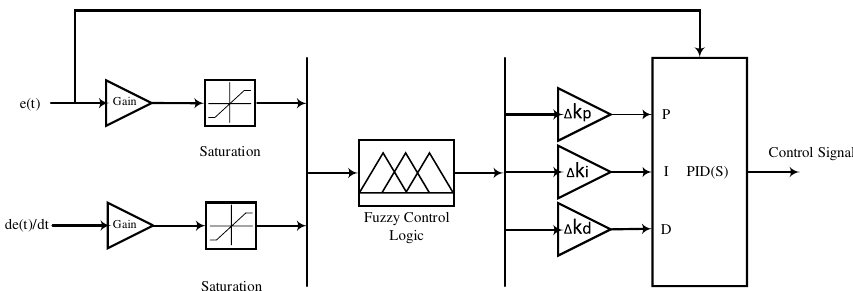
Fig. 10 The simulation block diagram of the fuzzy-PID controller